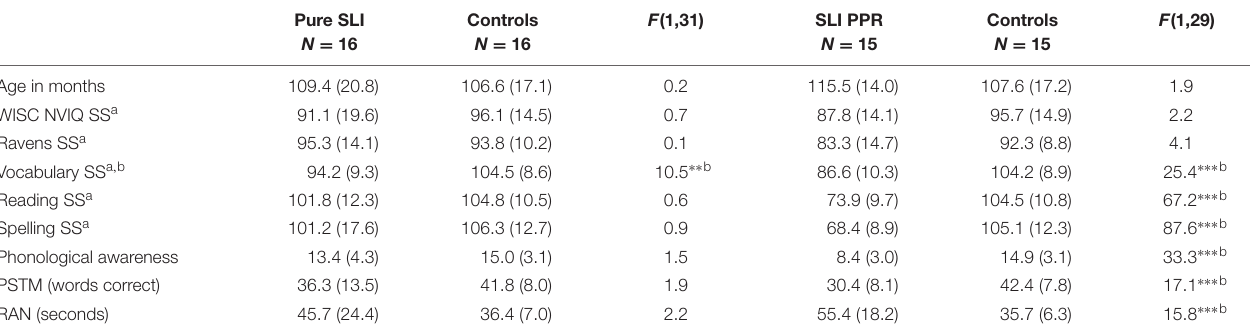
TABLE 6 | Participant characteristics by matched SLI sub-group.